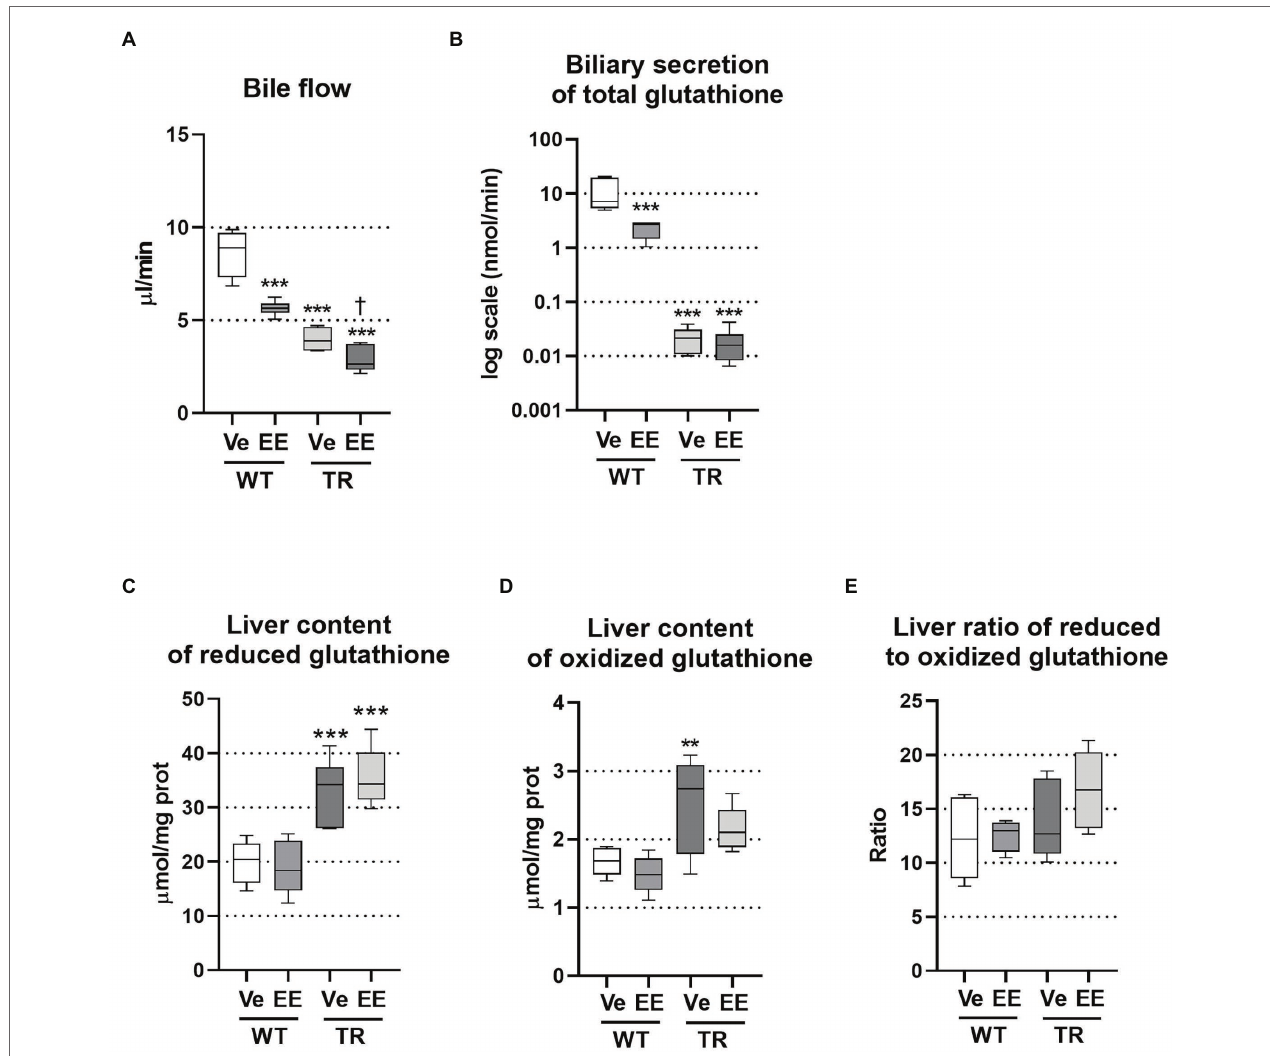
FIGURE 2 | Ethinylestradiol administration reduced bile flow in WT and TR animals. Experimental groups: WT-Ve, WT rats receiving vehicle; WT-EE, WT rats receiving ethinylestradiol; TR-Ve, TR rats receiving vehicle; and TR-EE, TR rats receiving ethinylestradiol. (A) Bile flow rate. (B) Biliary secretion of glutathione. (C,D) Reduced and oxidized glutathione was measured in liver lysates and normalized to protein content. (E) Ratio of reduced to oxidized glutathione in the liver. Data are presented as medians, with boxes and whiskers representing the interquartile range and 5th-95th percentiles, respectively. Significance: ** p < 0.01, *** p < 0.001 compared to vehicle-treated WT rats; † p < 0.05 compared to vehicle-treated TR